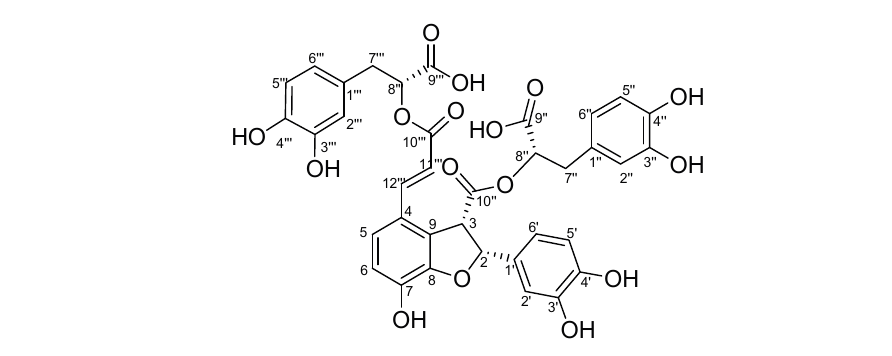
Figure 1. Structure of salvianolic acid Y (TSL